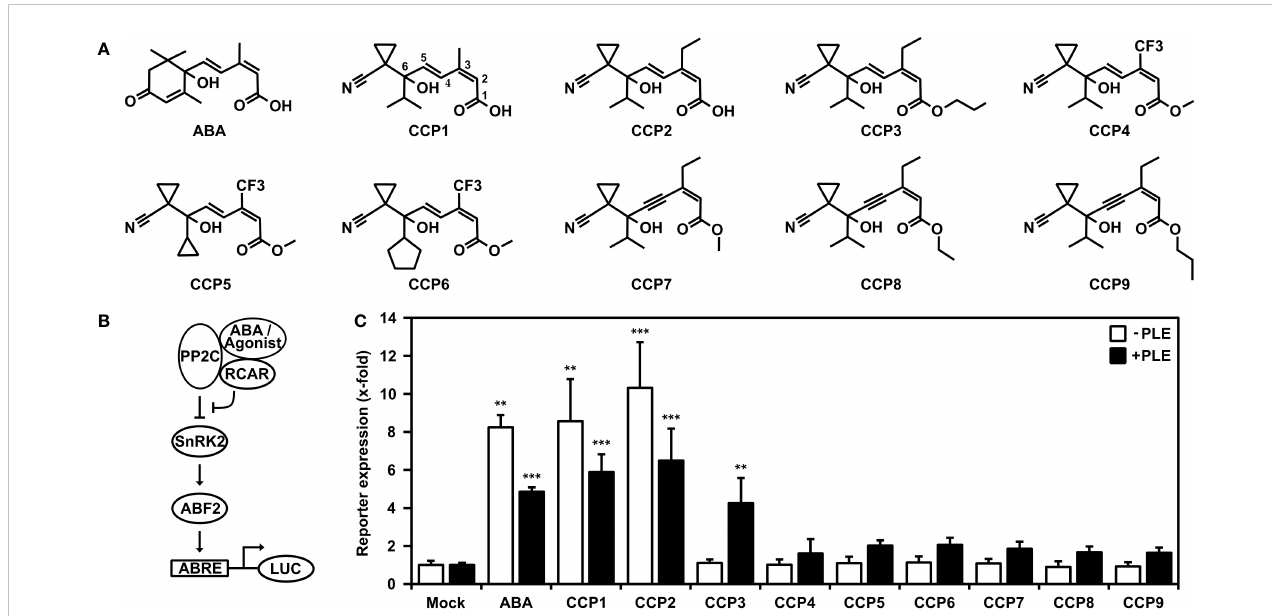
FIGURE 1 Activation of ABA signaling by ABA-related cyano cyclopropyl compounds in yeast. (A) Chemical structures of ABA and cyano cyclopropyl compounds CCP1 to CCP9. Carbon numbering is indicated for CCP1. (B) Scheme of the plant ABA signal pathway established in yeast. Binding of ABA or ABA agonists stabilizes the interaction of RCAR with the co-receptor PP2C, which inhibits the phosphatase and activates the signal pathway leading to reporter induction via the SnRK2-mediated phosphorylation of the transcription factor ABF2. The reporter gene consists of a minimal promoter with four copies of a synthetic ABA-responsive cis-element (ABRE) to drive the expression of a luciferase gene (LUC). (C) Reporter expression in yeast is upregulated by 30 µM ABA and CCPs. LUC activity was determined after 16 h of ligand exposure and normalized to yeast cell density. Induction of reporter response by CCPs either untreated (white bars) or treated with pig liver esterase (PLE; black bars) prior yeast exposure. The LUC activity of mock-treated cells without and with esterase pretreatment was set to 1. Mean ± SEM; n = 3 and n = 6 biological replicates, respectively. **P < 0.01, ***P < 0.001 (one-way ANOVA) compared to corresponding mock-treated yeast